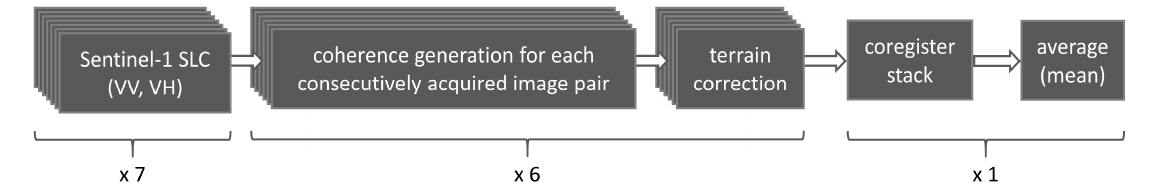
Figure 3. The main steps of the coherence processing chain applied automatically to the Sentinel–1 data in the CreoDIAS cloud environment. The numbers below show how the time series of seven images are reduced to one layer for each area in which the model is applied.